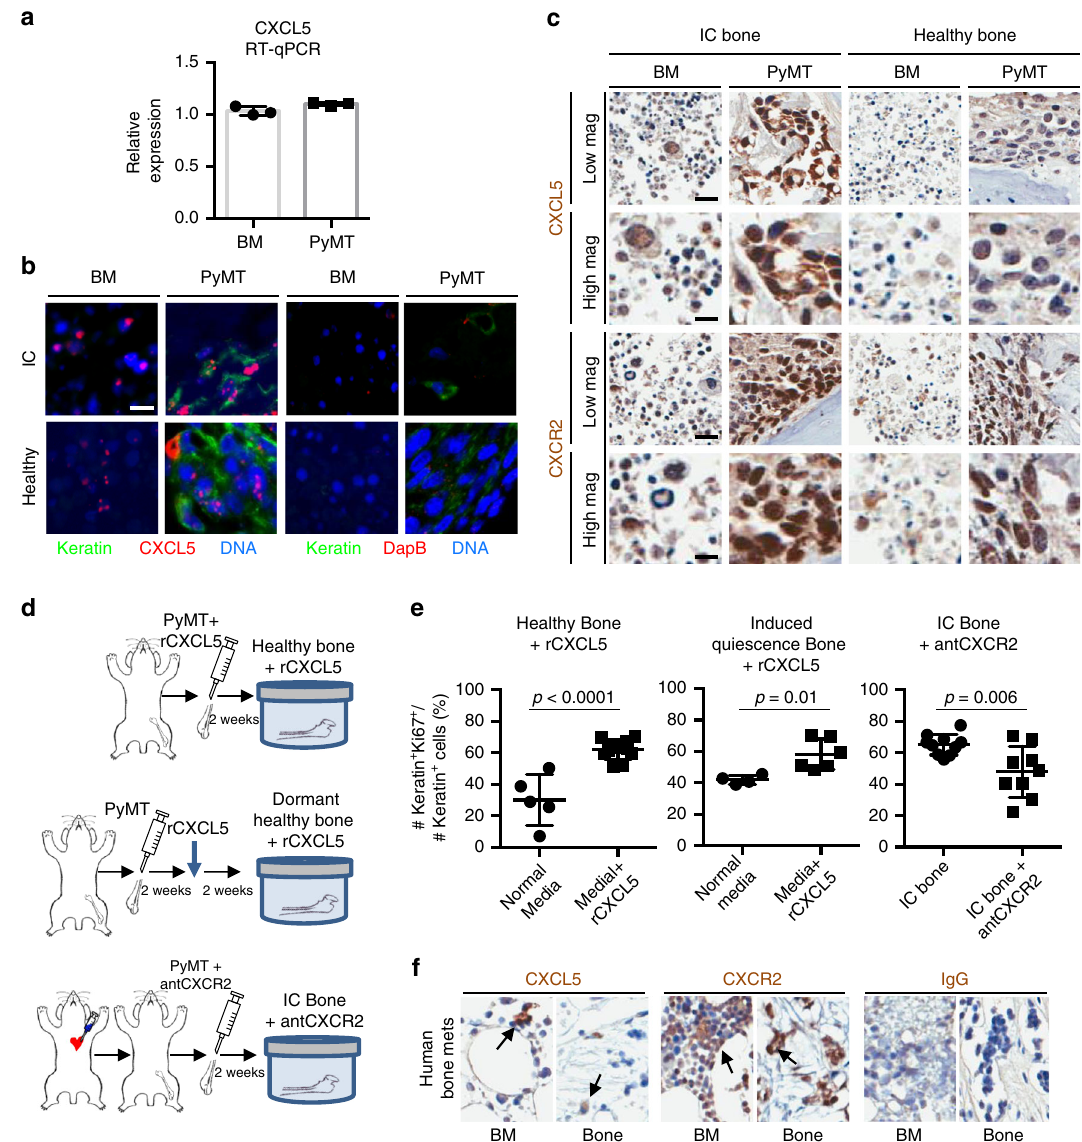
Fig. 3 CXCL5 and CXCR2 contribute to the regulation of proliferation. a RT-qPCR analysis for CXCL5 expression of bone marrow of healthy mice and PyMT cancer cells. b In situ hybridization (ISH) analysis of paraf fi n sections of healthy or IC mouse bone co-cultured for 2 weeks with PyMT cells. ISH fl uorescent probe (red) was used to detect RNA transcripts in the bone marrow and in Keratin + cancer cells (green). DapB ISH probe was used as a negative control (scale bar: 10 μ m). c IHC staining for CXCL5 and CXCR2 of healthy and IC bone co-cultures injected with PyMT cells (scale bars: Low magni fi cation = 20 μ m; High magni fi cation = 10 μ m). d Experimental design of ex vivo bone co-cultures. (Top) Healthy mouse bone explants supplemented daily